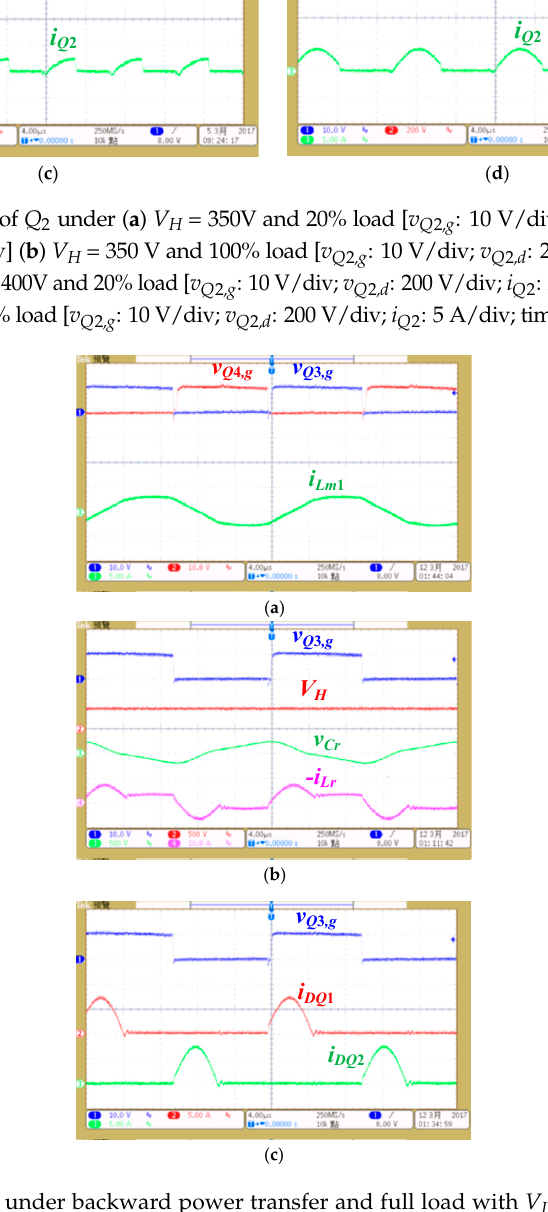
Figure 11. Test results under backward power transfer and full load with V L = 38 V ( a ) v Q 3 ,g , v Q 4 ,g and i Lm 1 [ v Q 3 , g , v Q 4 , g : 10 V/div; i Lm 1 : 5 A/div; time: 4 µs/div] ( b ) v Q3,g , V H , v Cr and − i Lr [ v Q 3 ,g : 10 V/div; V H , v Cr : 500 V/div; − i Lr : 10 A/div; time: 4 µs/div] ( c ) v Q 3 ,g , i DQ 1 and i DQ 2 [ v Q 3 ,g : 10 V/div; i DQ 1 , i DQ 2 : 5 A/div; time: 4 µs/div].